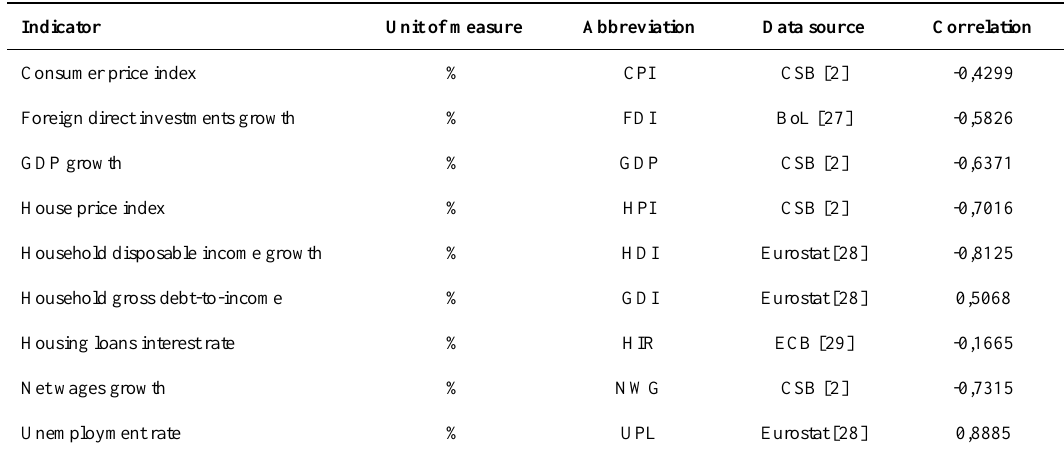
Table 2. Macro indicators and their correlation with